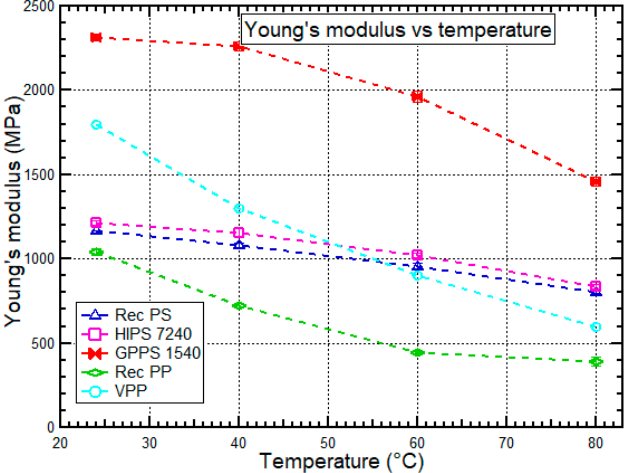
Figure 6. Young’s modulus vs. temperature behavior for HIPS 7240, GPPS 1540, recycled PS, recycled PP, and virgin PP at 24 °C, 40 °C, 60 °C, and 80 °C. Data for virgin PP was obtained from Mallick et al. [46].